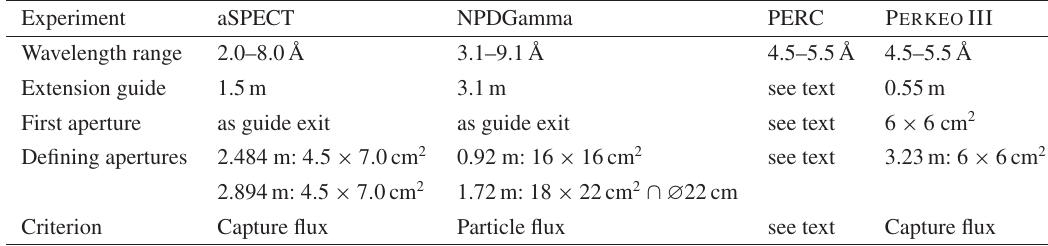
Table 4. Parameters of the reference experiments used in the simulations. The extension guide bridges the distance between the exit of the ANNI guide and the start of the collimation system, in order to place the experiment itself at the start of the experimental area, and has the same cross-section and m value as the ANNI guide. For important apertures the distance to the end of the extension guide and the cross-section are given. Criterion indicates the quantity that was used for optimisation; it is measured after the last aperture. The PERC setup is too different and is described in the